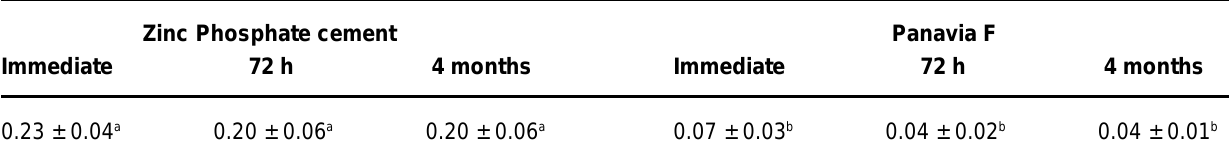
TABLE 1- Tensile force values (kN) required for post dislodgment after different periods between root canal obturation and post cementation with the two cements